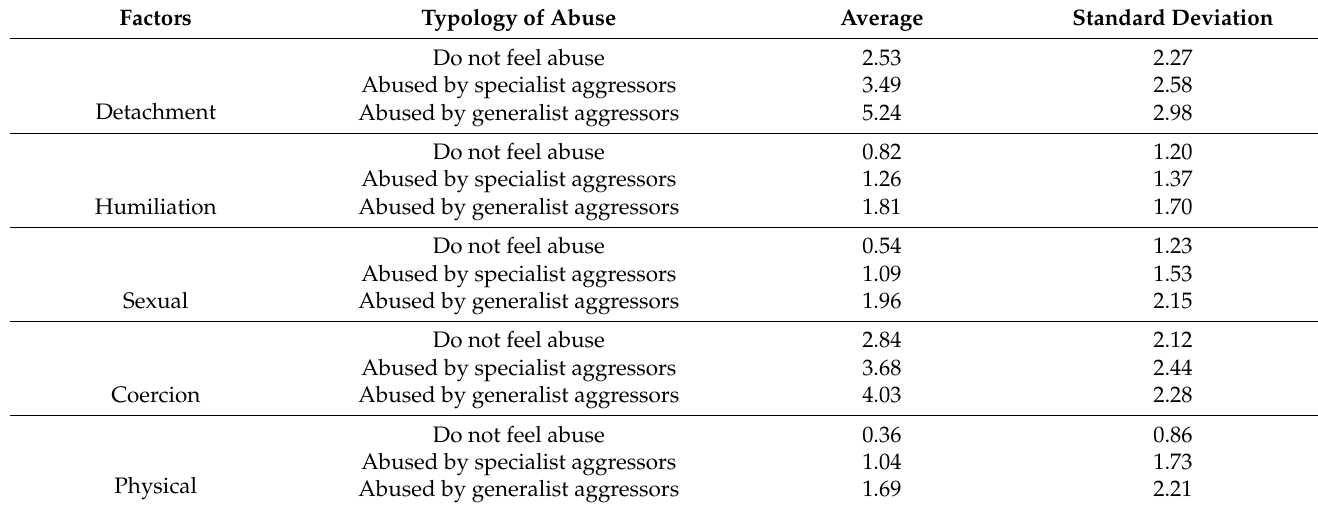
Table 6. Descriptive analyses of the factors of abuse with respect to the self-perception of